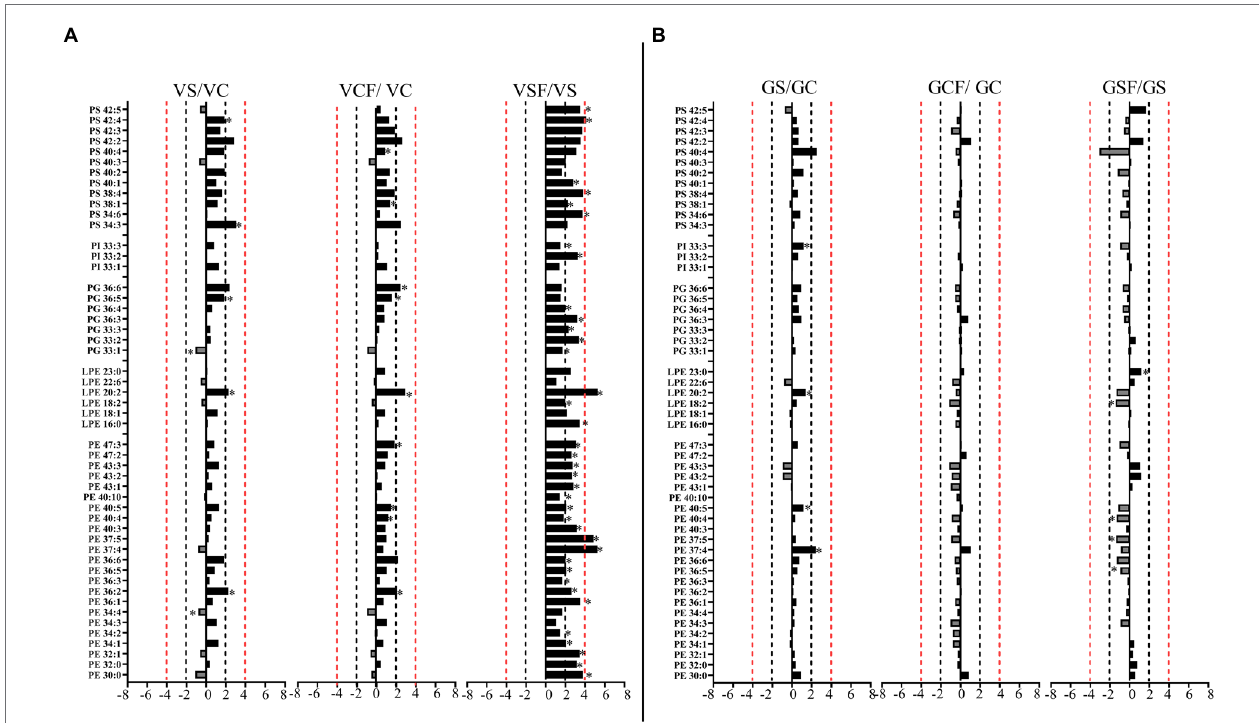
FIGURE 8 | Logarithmic ratios of representative phosphatidylethanolamine (PE), lysophosphatidylethanolamine (LPE), phosphatidylglycerol (PG), phosphatidylinositol (PI) and phosphatidylserine (PS) content in roots of barley cv. Vlamingh (V) given as (A) and cv. Gairdner (G) given as (B) , showing three comparisons—salt grown (200 mM NaCl) vs. control grown ( VS /VC and GS/GC); control with fungus vs. control grown (VCF/VC and GCF/GC); salt and fungus grown vs. salt grown (VSF/ VS and GSF/GS). An asterisk ( * ) indicates that the values are significantly different ( p < 0.05, FDR). A black dashed line indicates a 2-fold change threshold, whereas a red dashed line indicates a 4-fold change threshold. All treatments included a total of six replicates ( n =